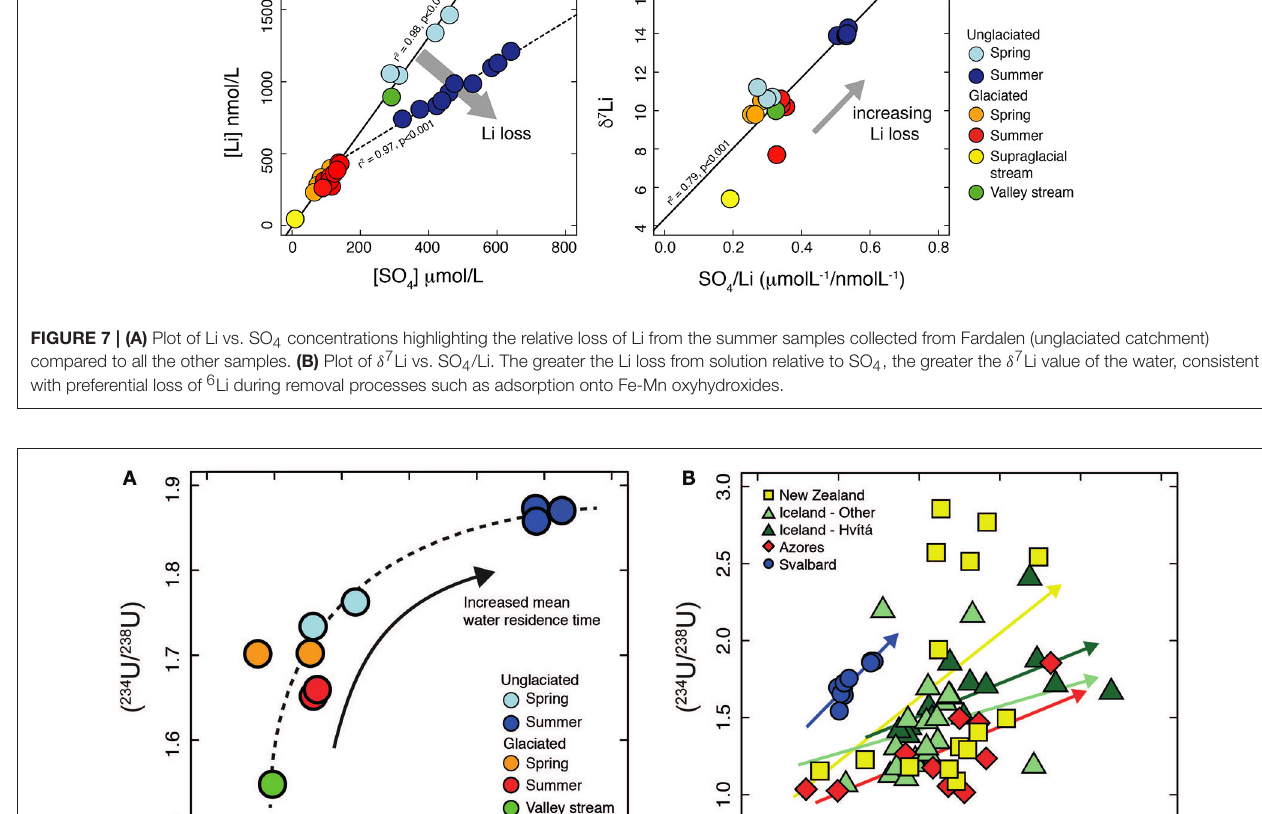
Frontiers in Earth Science |